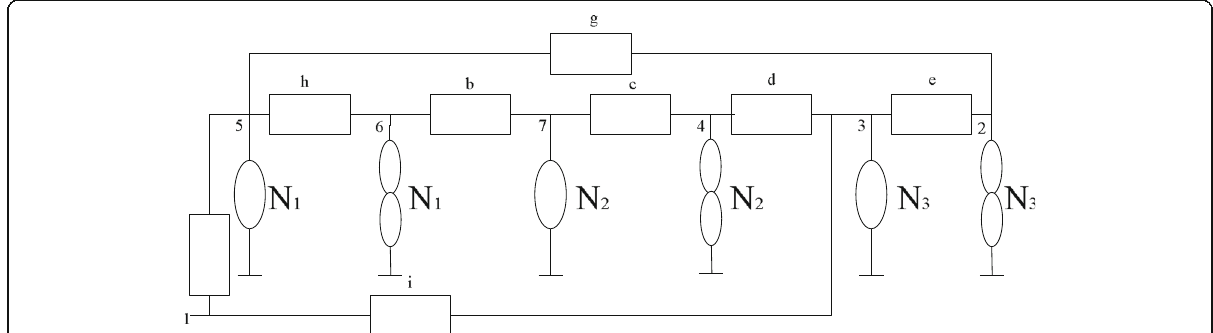
Fig. 8 The circuit topology synthesized from Eq.